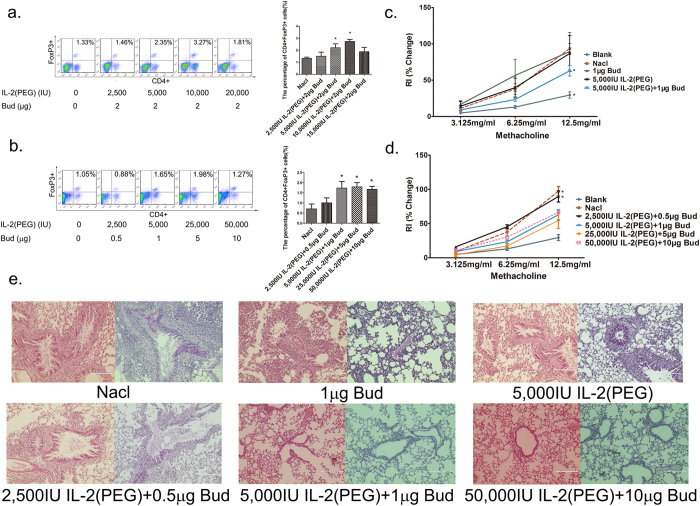
Treg cell, lung resistance and lung tissue analysis after intervention with various ratios or doses of IL-2(PEG) and budesonide.Female BALB/c mice were immunized with OVA i.p on days 1 and 8, followed by intranasal (i.n) 2% OVA challenges on days 9–14. Drugs were administrated intratracheally on days 12–14. On day 15, mice were sacrificed and analyzed. (a) Treg cell composition was analyzed by flow cytometry after intratracheal administration of various ratios of IL-2(PEG) and budesonide(Bud) for 3 days in asthma model mice. It showed that a ratio of 5,000 IU IL-2(PEG):1 μg Bud was optimal. (b) Treg cell analysis after intratracheal administration of different doses of IL-2(PEG) plus Bud combined in a fixed ratio of 5,000 IU IL-2(PEG):1 μg Bud for 3 days in asthma model mice. (c–e) AHR measurement and images of lung sections (scale bars, 200 μm) in asthma model mice treated with different drugs. Results represent the changes in lung resistance (Rl) as a measure of AHR. *p < 0.05. (a,b) Data are presented as means ± SEM (n = 8 per group and data point). Treated group versus untreated group by Student’s t test. (c) Data are presented as means ± SEM (n ≥ 4 per group and data point); here representative results from 1 of 2 experiments are shown. Other group versus Nacl group by Student’s t test. (d) Data are presented as means ± SEM (n ≥ 4 per group and data point); here representative results from 1 of 2 experiments are shown. Treated group versus blank group by Student’s t test. (e) Left, H&E staining; right, PAS staining. Blank group, health control mice. Nacl group, asthma model mice treated with normal saline.